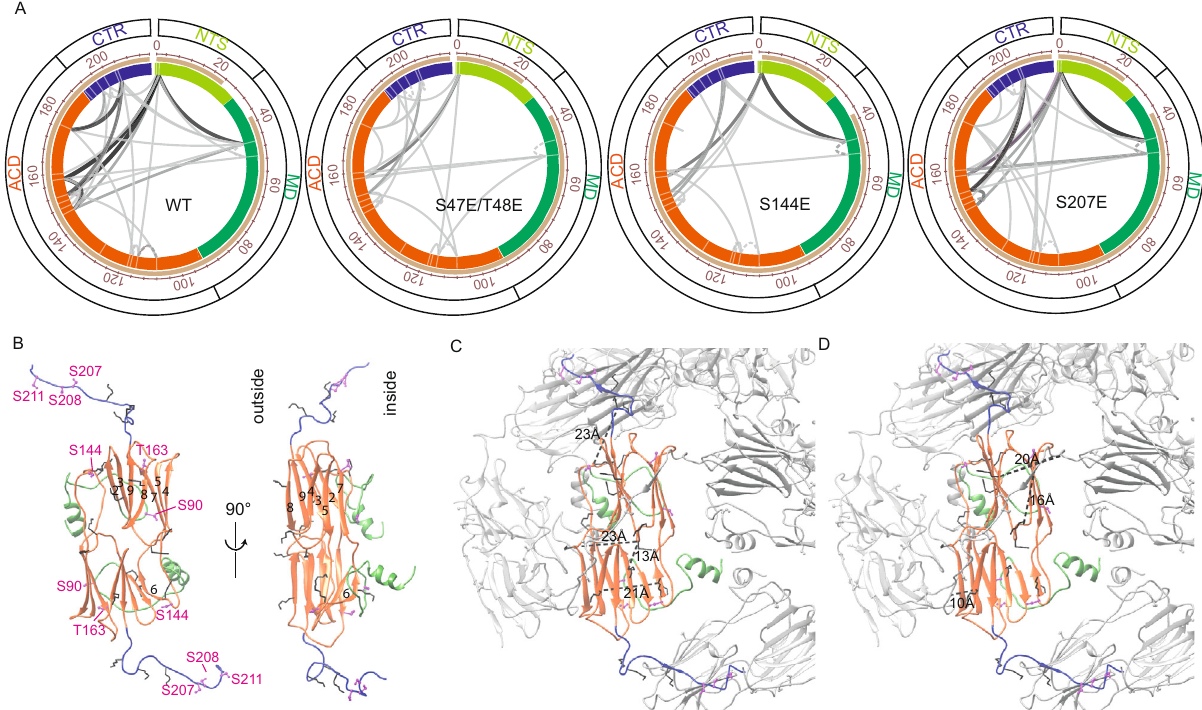
Fig. 5 Phosphomimetic mutations lead to an unlocking of the MD. A Hsp26 (20 µ g) was crosslinked by the addition of 2.7 mM DSG for 1 h at 25 °C. MS measurements were performed on a Thermo Fusion mass spectrometer and the data evaluated in Kojak and visualized with Proxl. The crosslinks are indicated by lines connecting the respective residues. The thickness and color of the lines correspond to the number of peptide spectrum matches (light gray: PSMS = 1 – black: PSMS = 5). Dashed lines represent loop-links. White lines in the schematic sequence representation indicate possible crosslink positions. The beige bar represents the sequence coverage. All proteins were measured in triplicates, whereas only one exemplary replicate is shown. B Two views of the pseudo-atomic model with the ribbon colored as in Fig. 1A. Potential phosphorylation sites in the stick and ball representation are colored magenta and lysine residues involved in crosslinking as stick model are colored black. C Measured intra-dimer crosslinks were mapped on one exemplary dimer and shown as black dashed lines. Distances between the C α atoms were measured in Chimera and are indicated the pictures. D Measured inter- dimer crosslinks are indicated by black dashed lines in the structure segment. Distances between the C α atoms were measured in Chimera and are indicated in the